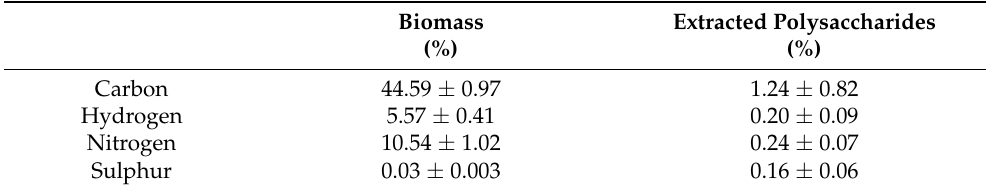
Table 1. Total Carbon (C), Hydrogen (H), Nitrogen (N), and Sulphur (S) obtained in the biomass and extracted EgPs.